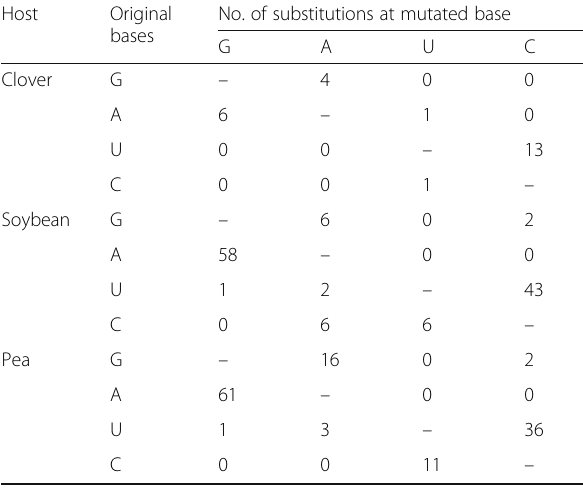
Table 4 Substitution types of SbDV-MD6 populations in different host